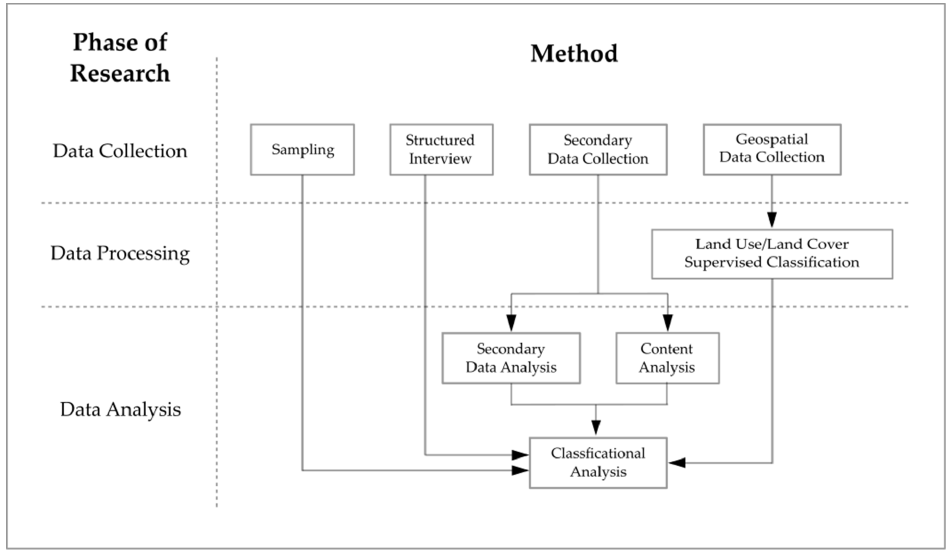
Figure 6. Methodology of the